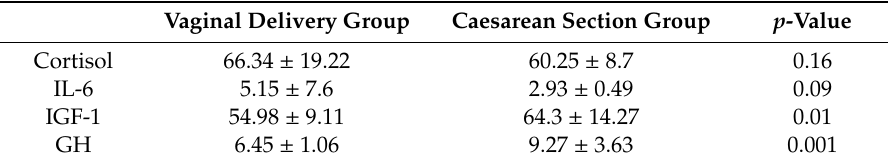
Table 3. Mean umbilical cord hormonal levels reported for the vaginal delivery and cesarean section